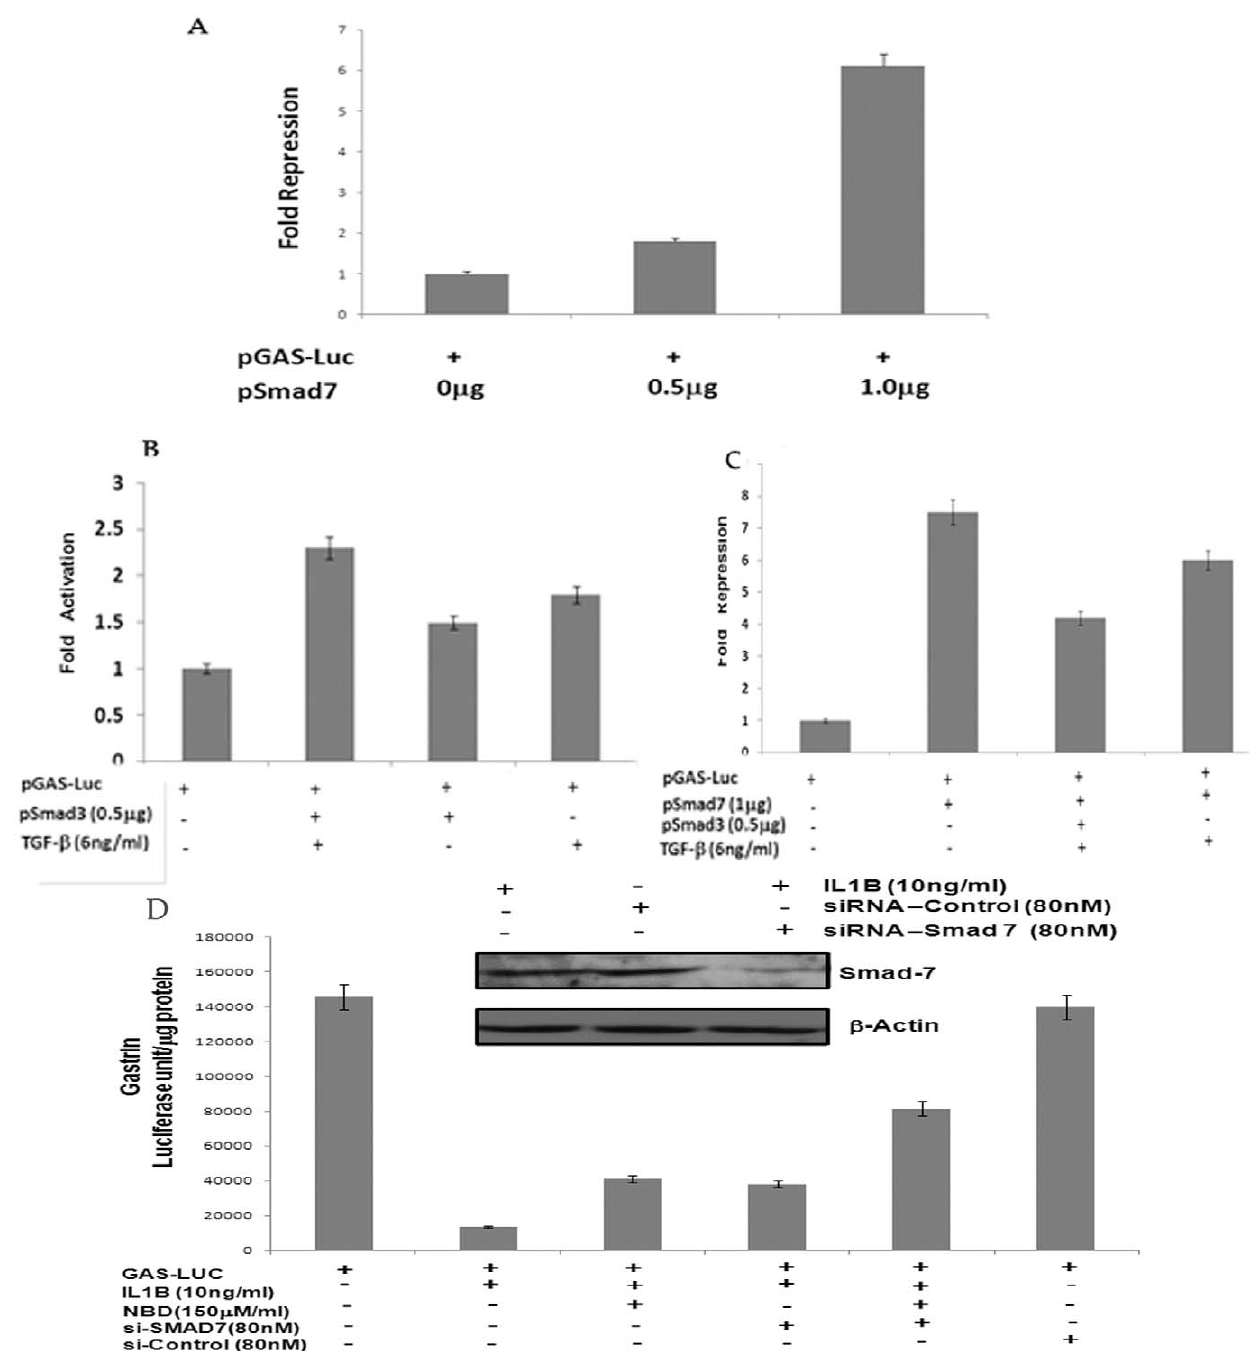
Figure 4. Effect of Smad 7 on gastrin promoter activity. AGS cells were cotransfected with (A) Gas-Luc construct and increasing amount of Smad 7 expression vector (B) Gas-Luc construct and Smad 3 expression vector along with treatment with recombinant TGF-beta for 20 hours (C) Gas- Luc construct and either Smad 7 or both Smad 3 and Smad 7 expression vectors with or without stimulation with recombinant TGF-beta for 20 hours. Cells were harvested 48 hours after transfection and luciferase activity was measured. The mean luciferase activity of three different experiments is represented as fold activation or repression with respect to gastrin promoter alone and graphically plotted. These experiments establish that Smad 7 downregulates gastrin (D) AGS cells were transfected with Gas-Luc construct after the treatment with either si-RNA against Smad 7 or Control scrambled si-RNA for 24 hours. After 44 hours of Gas-Luc transfection, cells were either incubated with NBD (150 m M/ml) or left untreated. Next, cells were stimulated with recombinant IL1B (10 ng/ml) at 46 hours from Gas-Luc transfection or left untreated. Cells were then harvested 48 hours after transfection of Gas-Luc and luciferase activity was measured. The mean luciferase activity of three different experiments is represented as fold activation or repression with respect to gastrin promoter alone and graphically plotted. This experimental observation concludes that both Smad 7 and NFkB pathways contribute equally in IL1B mediated inhibition of gastrin expression. (Inset shows representative Western Blot for Smad7 in Smad 7-siRNA treated and untreated lysates.)